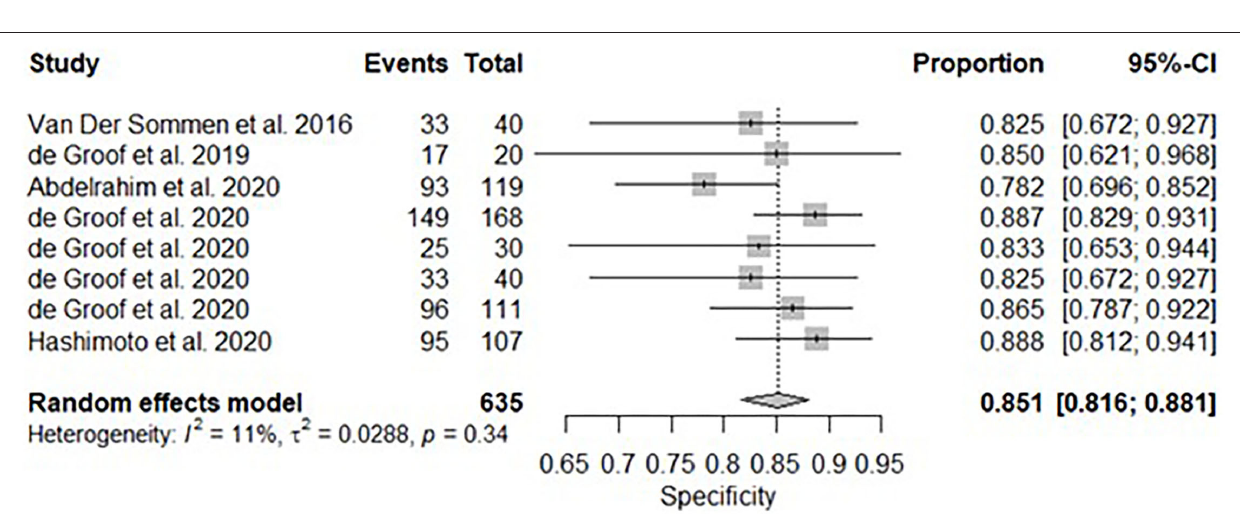
FIGURE 9 | Forest plots of pooled specificities for included studies of AI and the detection of early BE neoplasia (White Light Endoscopy only) – Subgroup